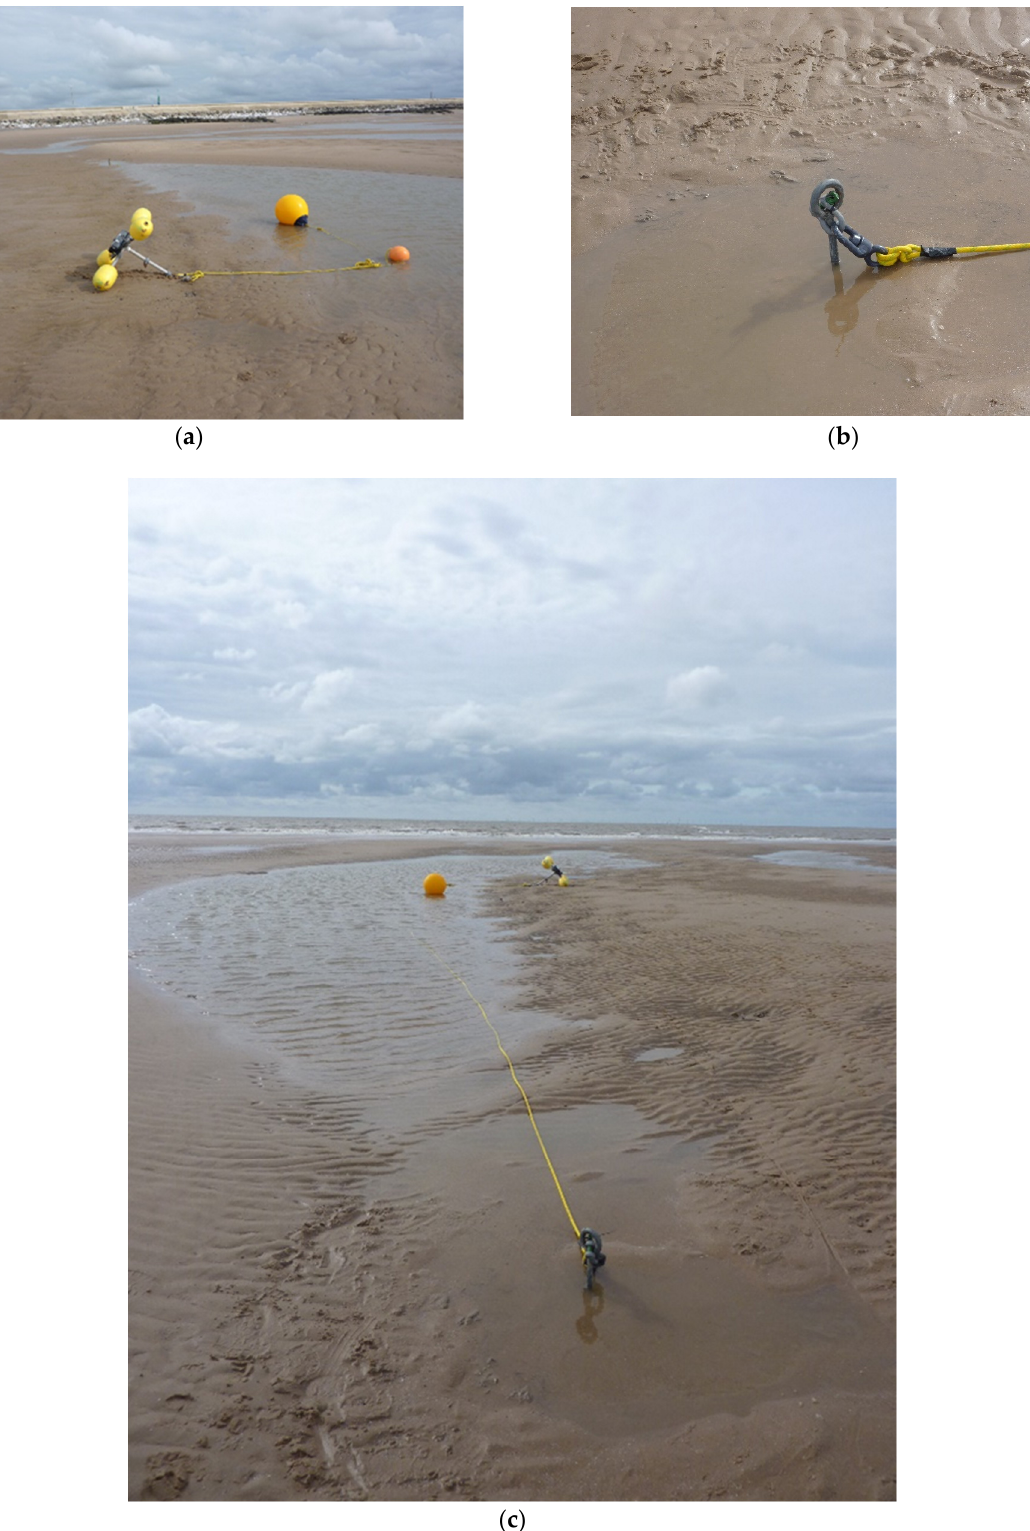
Figure 1. ( a ) Top part of mooring together with the GNSS buoy, ( b ) ground anchor with swivel, ( c ) complete mooring installed and laid out on the beach at low water.